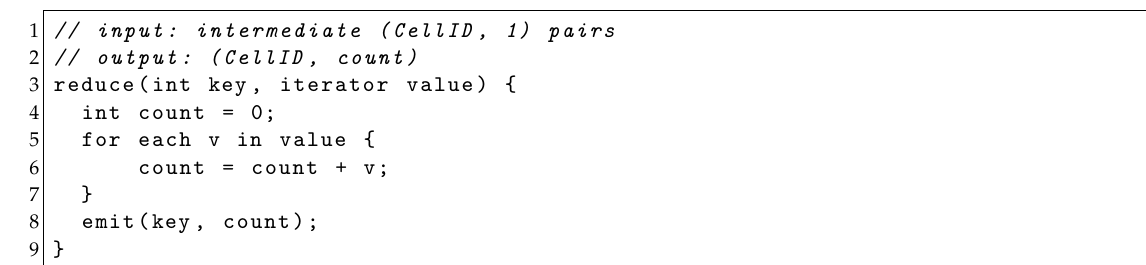
Figure 5. Map Function for Cell Phone Count.